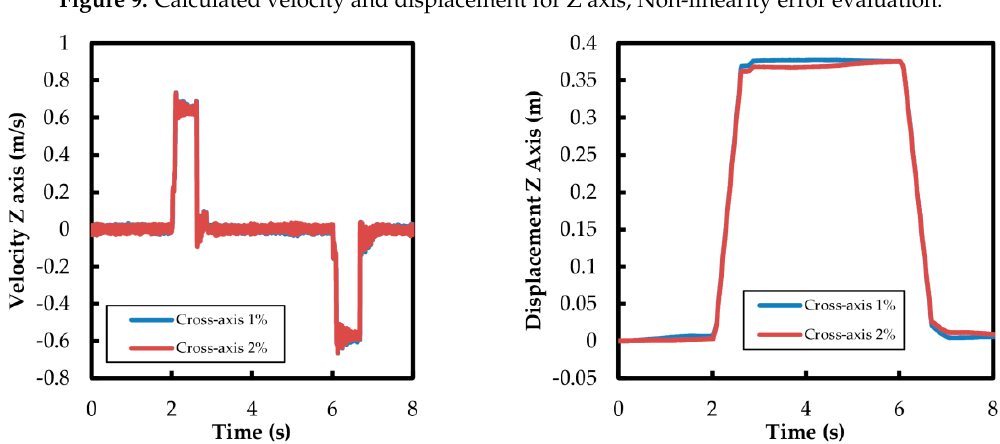
Figure 10. Calculated velocity and displacement for Z axis; Cross-axis sensitivity error evaluation.